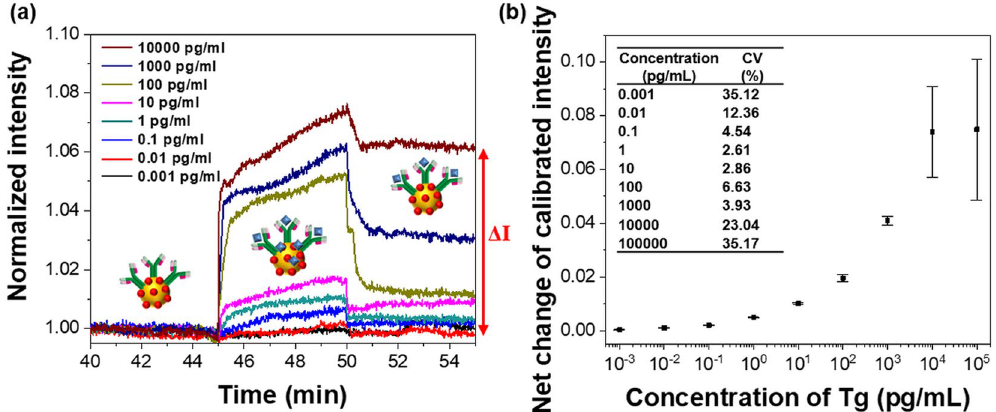
Figure 4. Results of Tg detection in various levels: ( a ) sensorgram recorded in real-time and ( b ) ΔI measured three times at each concentration and CVs (CV = (standard deviation/mean) ×